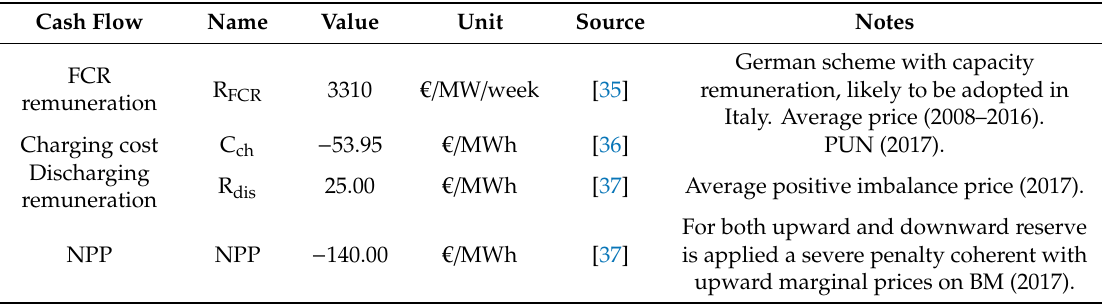
Table 4. Economic indicators adopted in the